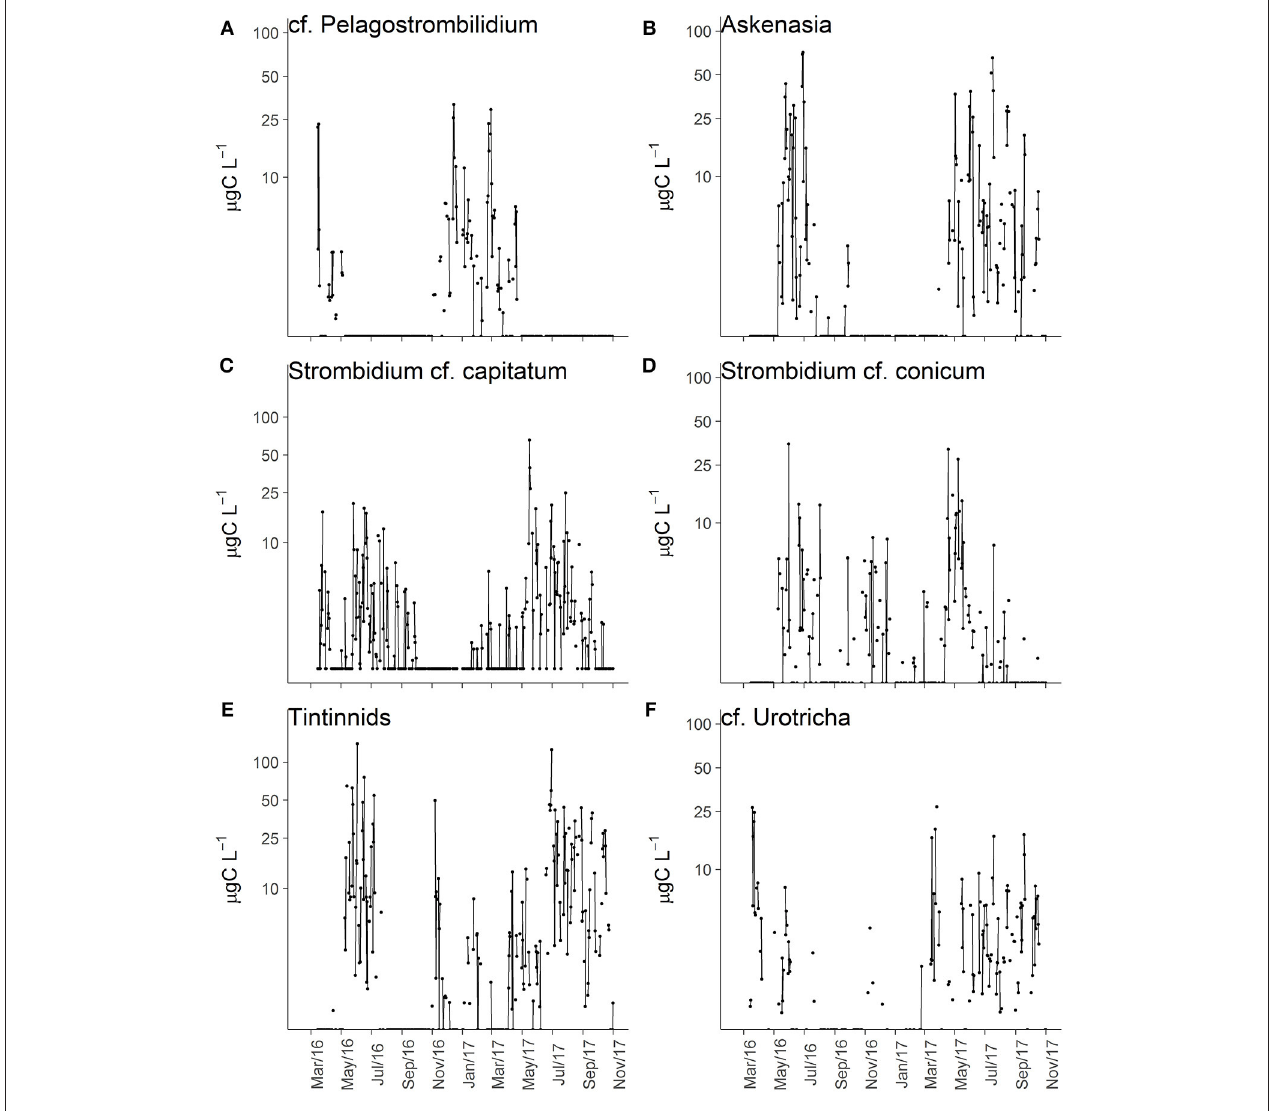
FIGURE 4 | Biomass variations over time for selected ciliates morphotypes: cf. Pelagostrombilidium (A) , Askenasia (B) , Strombidium cf. capitatum (C) , S . cf. conicum (D) , Tintinnids (E) , and cf. Urotricha (F)